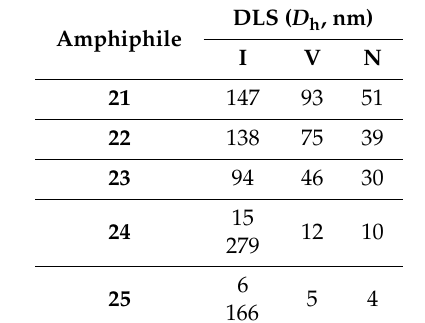
Table 3. Particle size distribution profile of amphiphile self-assemblies above the CAC in aqueous solution as measured by dynamic light scattering (DLS) at 25 ◦ C.